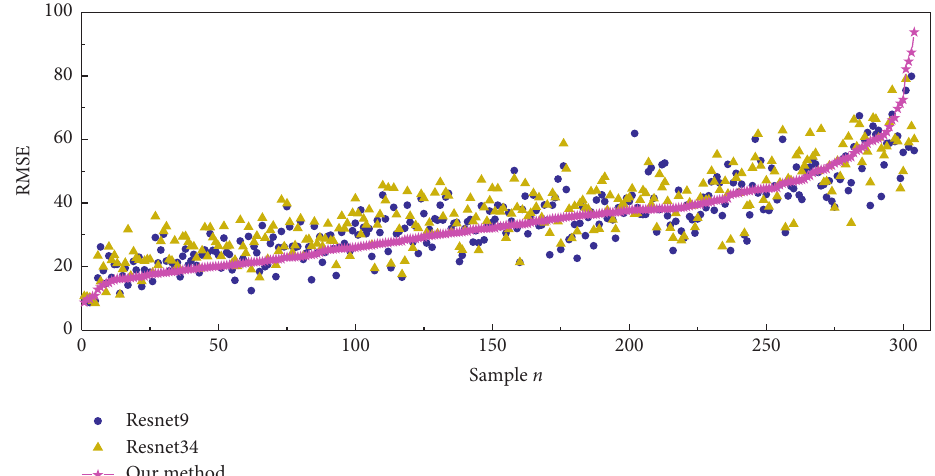
Figure 9: The RMSE results between the real infrared images and the infrared images generated by our method and the Resnet9 and Resnet34. The X -axis represents different test samples and the Y -axis represents the RMSE value corresponding to the sample.